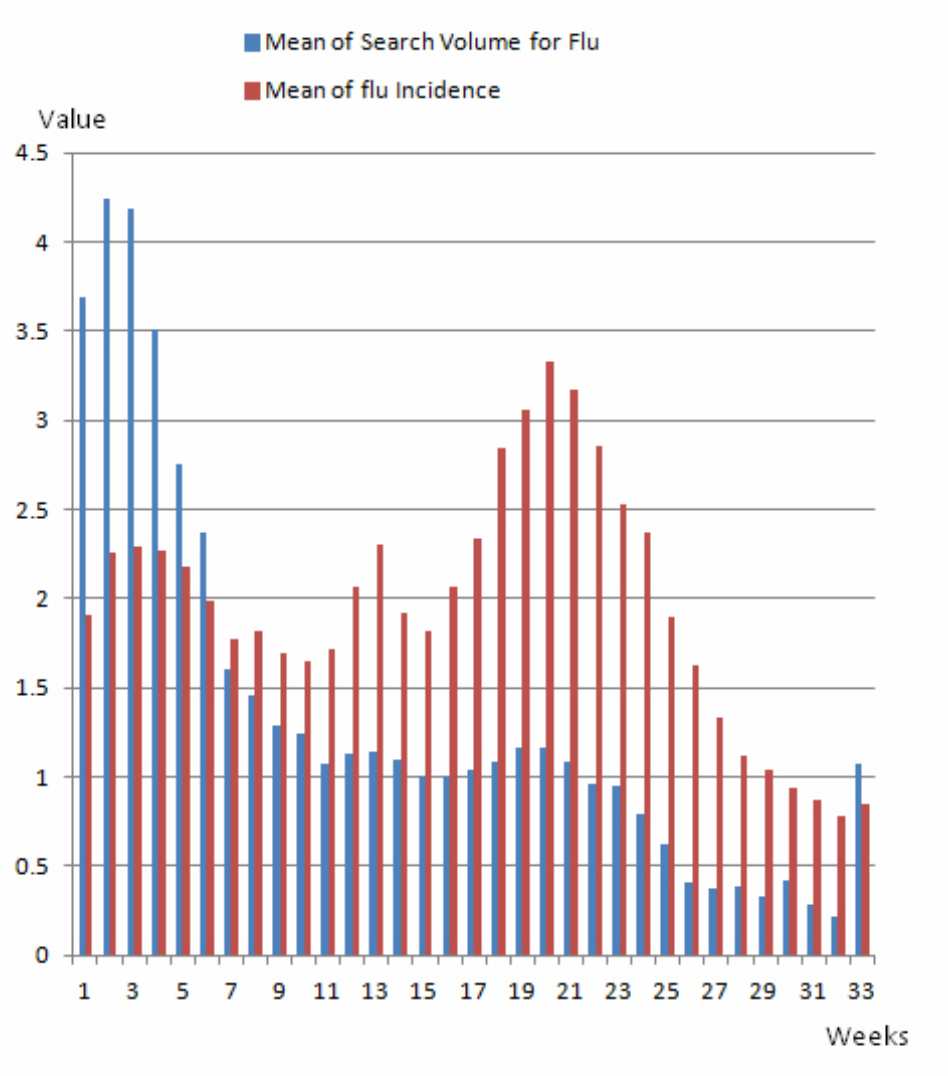
Figure 1. Trends of the means of search volumes for flu and the incidence of the